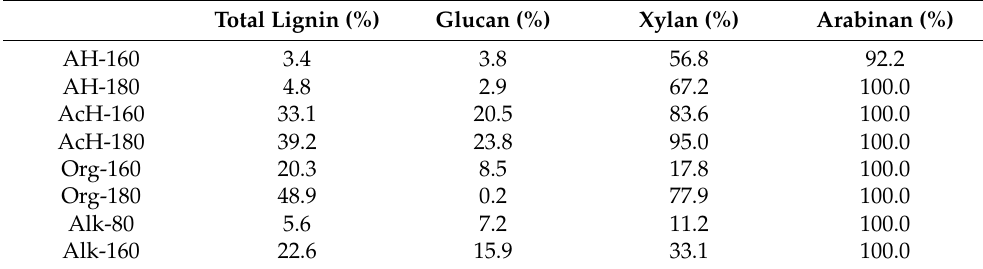
Table 3. Removal of lignin and the specific carbohydrates using different pretreatment methods per gram of each component in raw